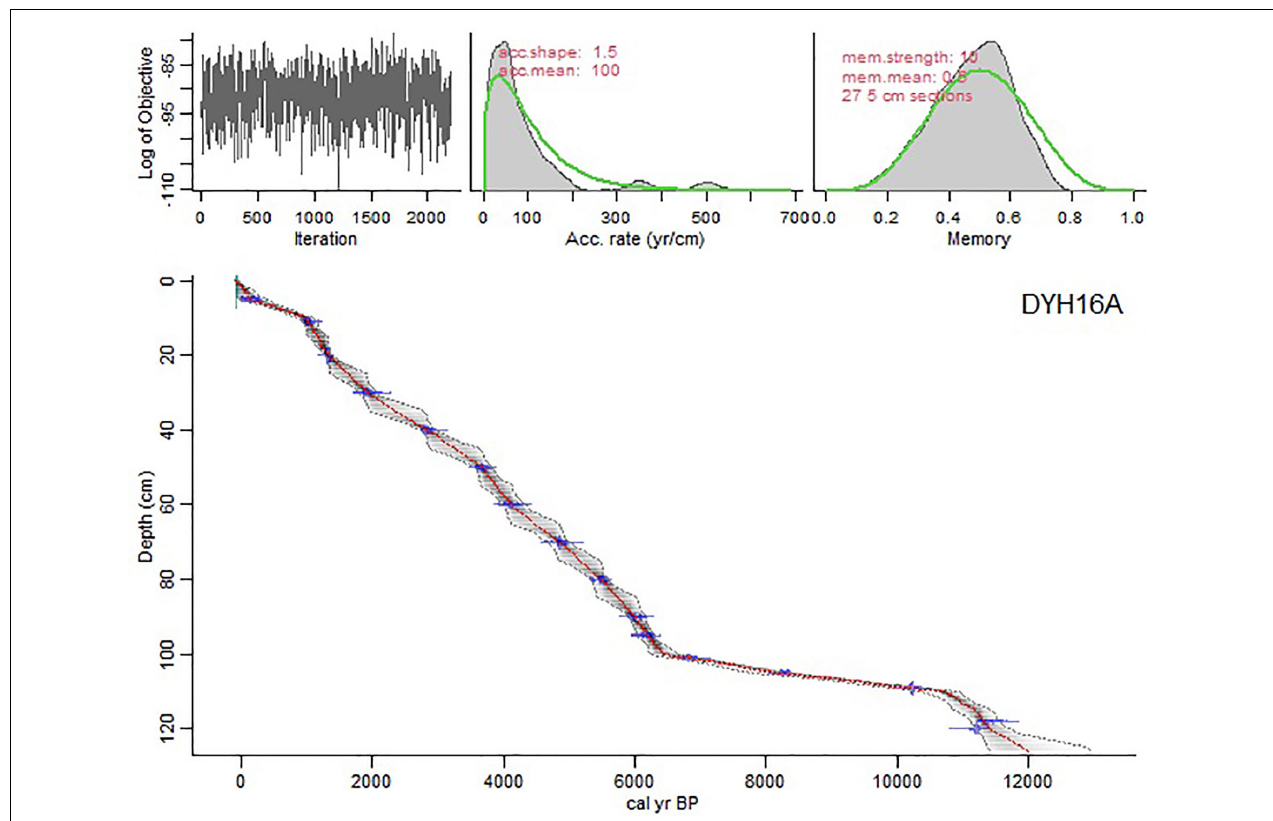
FIGURE 2 | AMS 14 C dates for core DYH16A from Daye Lake based on the R package rbacon, version 2.5.0 (Blaauw and Christen, 2011) and the resulting age-depth model. The red line represents mean calendar years. The gray shading and the blue line indicate calendar ages with the 95% confidence range and the age errors, respectively.